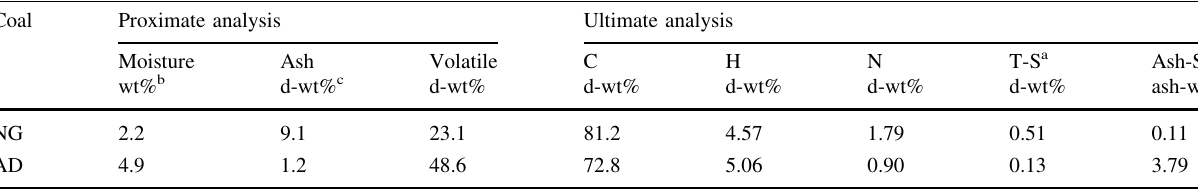
Coal Proximate analysis Ultimate